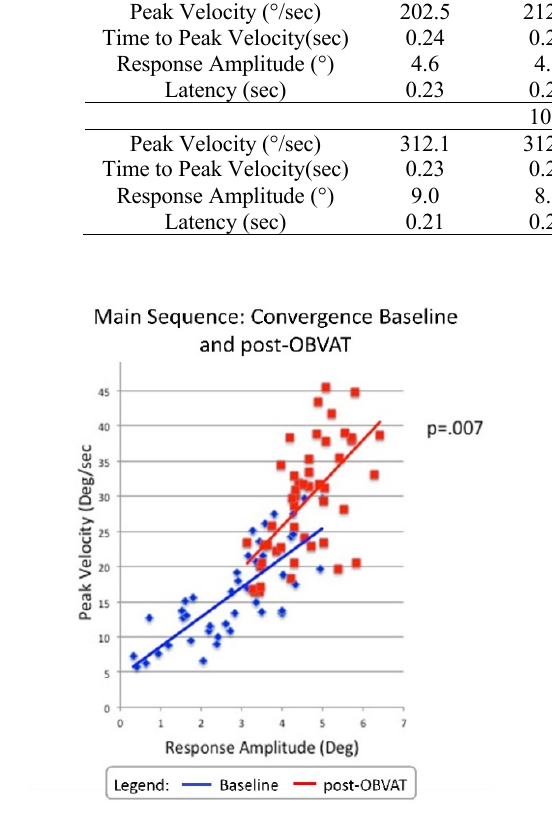
Figure 2: Main sequence for convergence pre- vs post-OBVAT